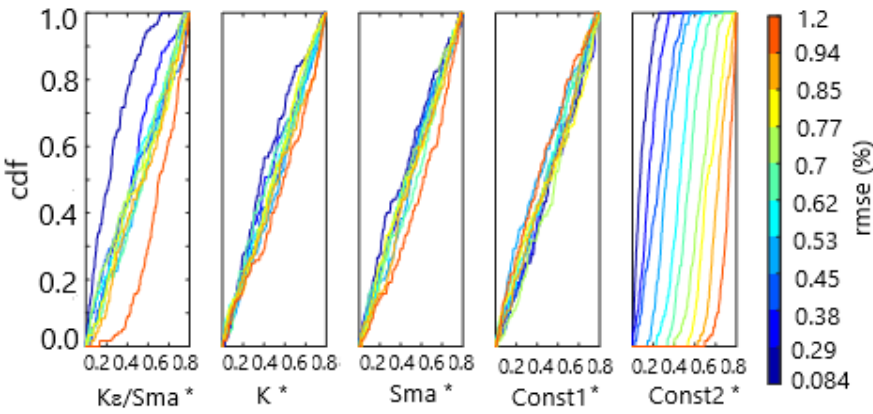
Figure 10. Cdf for the eddy viscosity ( ν T ), for St1.